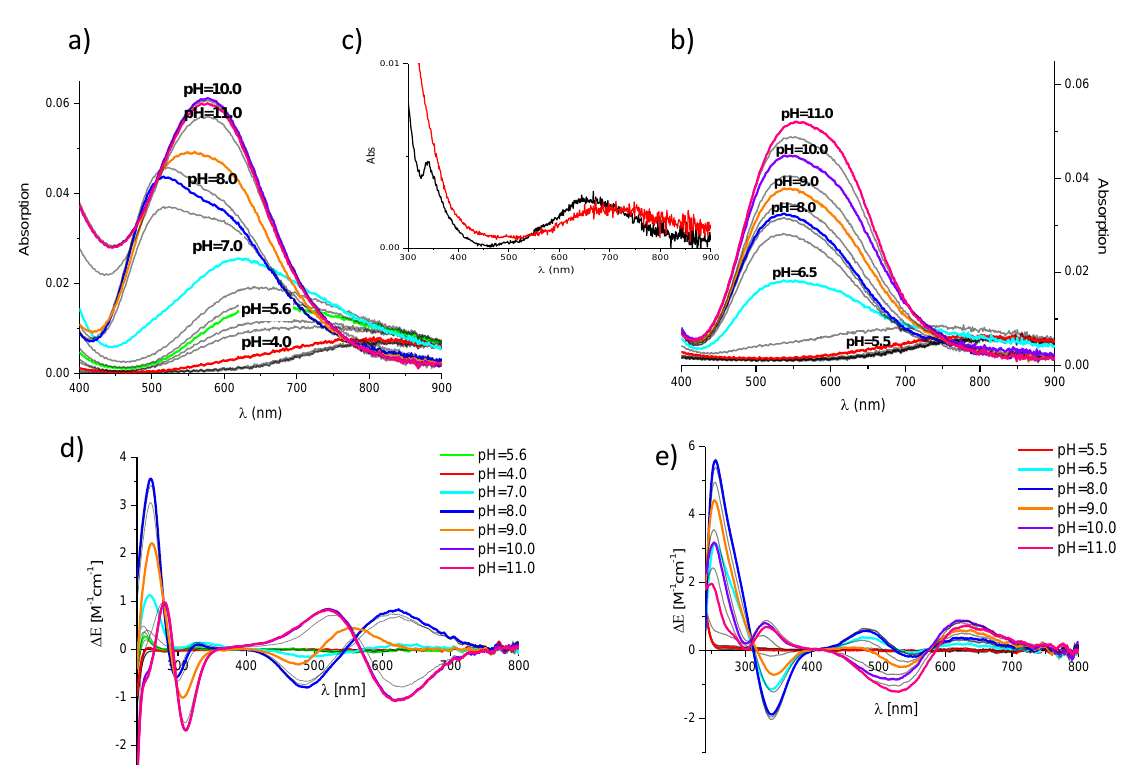
Figure 2. The UV-Vis spectra for the solution with an equimolar quantity of ( a ) L1 and Cu(II) ions and ( b ) L2 and Cu(II) ions, at pH between 2.5 and 11.0. ( c ) The comparison of the experimental spectra for L1 at pH 4.0 (black) and L2 at pH 5.5 (red) obtained by the subtraction of the Cu(H 2 O) 62+ spectrum. The CD spectra for the solution with an equimolar quantity of ( d ) L1 − c(GlyHisProHisLys) and ( e ) L2 − c(GlyHisGlyHisLys) with Cu(II) ions at pH between 2.5 and 11.0.